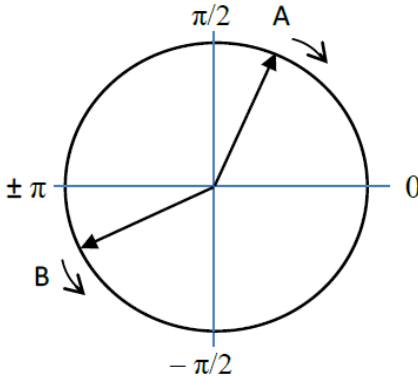
Figure 1. The role of the parametric phase-pulling effect for P 2 = P 3 > P 1 >> P 4 in shifting θ towards π /2, for any input signal phasor.